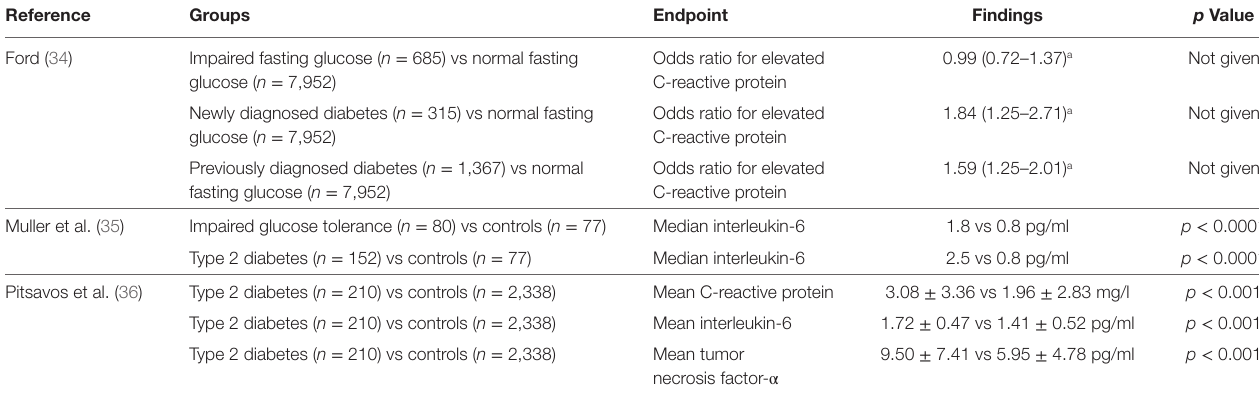
TABLe 1 | Cross-sectional studies of C-reactive protein, interleukin-6, and tumor necrosis factor- α in type 2 diabetes.